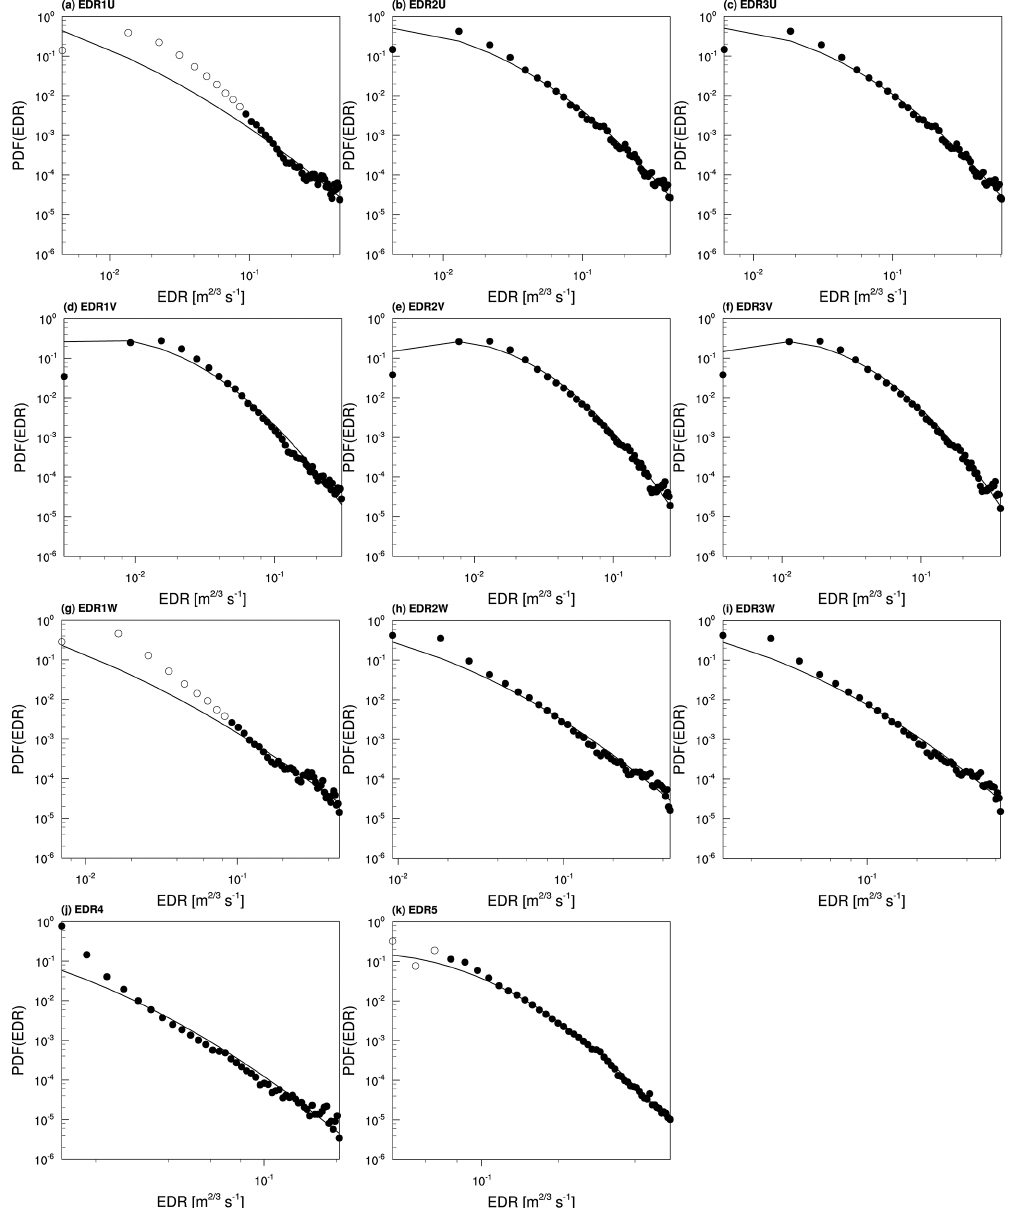
Figure 9. As in Fig. 8 but for